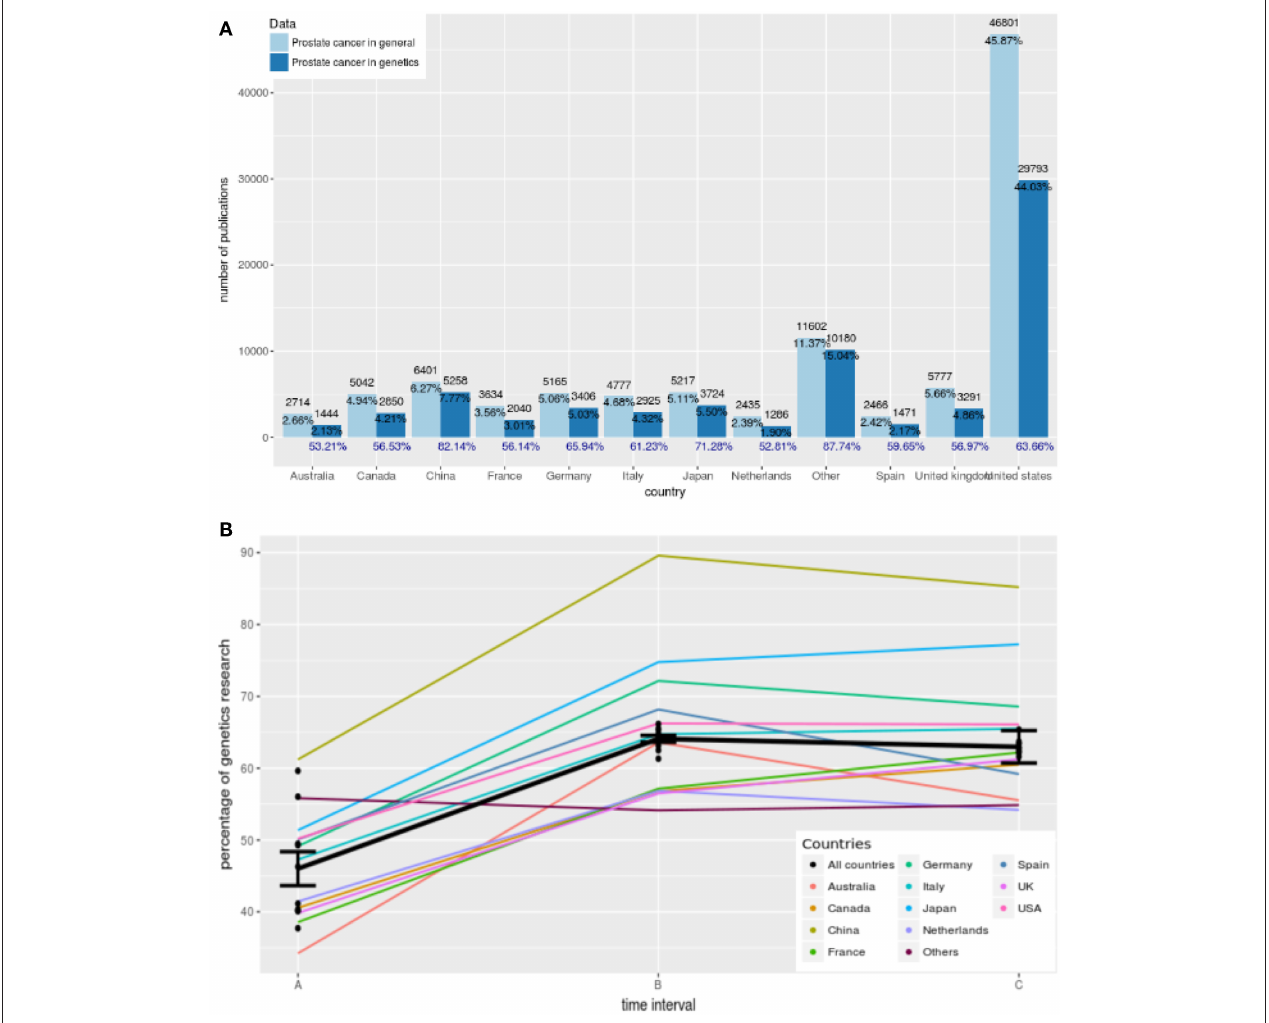
FIGURE 4 | (A) Country-specific contributions to prostate cancer research from 12 countries. Dark blue corresponds to results for prostate cancer research in genetics and light blue corresponds to results for general prostate cancer research. The percentages in blue give the country-specific contributions to genetics research. (B) Trends of genetics research from 1987 to 2018 showing the percentage of genetics research. The time intervals correspond to A: 1987–1996, B: 1997–2006, and C: